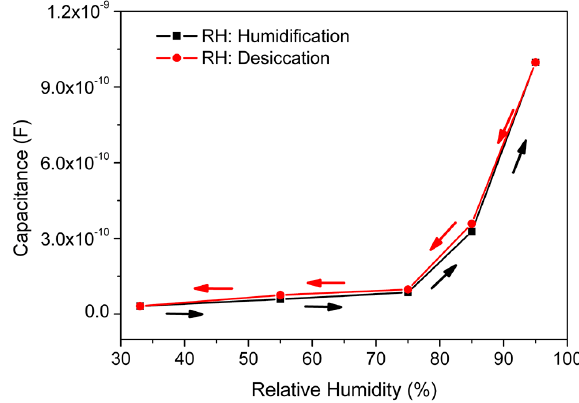
Figure 10. The hysteresis property of CMFTO electro-ceramic-based capacitive humidity sensor at 10 2 Hz under 25 ° C. Note: the value of hysteresis is extremely low (~3.2%) compared to other conventional capacitive sensors. The low hysteresis value is mainly due to the fast adsorption and desorption rate of water particles on the surface of the CMFTO electro-ceramic.